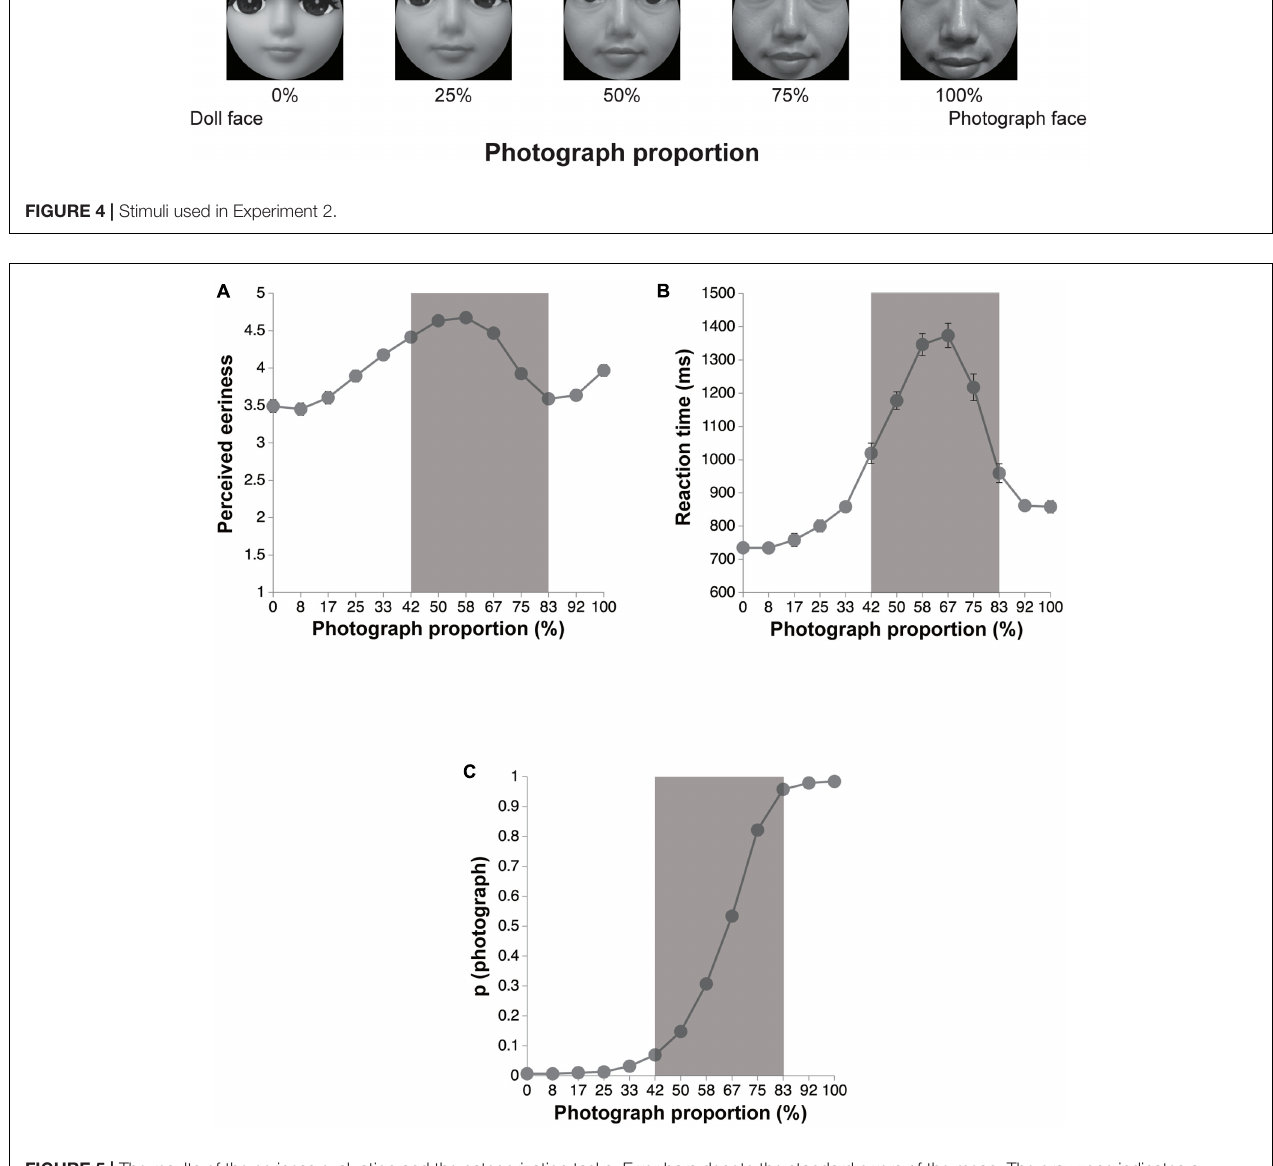
FIGURE 5 | The results of the eeriness evaluation and the categorization tasks. Error bars denote the standard errors of the mean. The gray zone indicates a hard-to-categorize interval (42–83%). (A) The perceived eeriness for each photograph proportion. (B) Mean RT as a function of photograph proportions. (C) The proportions of photograph responses as a function of photograph